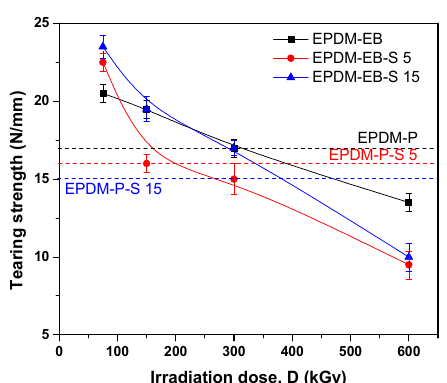
Figure5. Theinfluenceofsawdustamountandcross-linkingmethod(P / EB)oncompositestearingstrength. Figure 5. The influence of sawdust amount and cross-linking method (P/EB) on composites tearing strength.